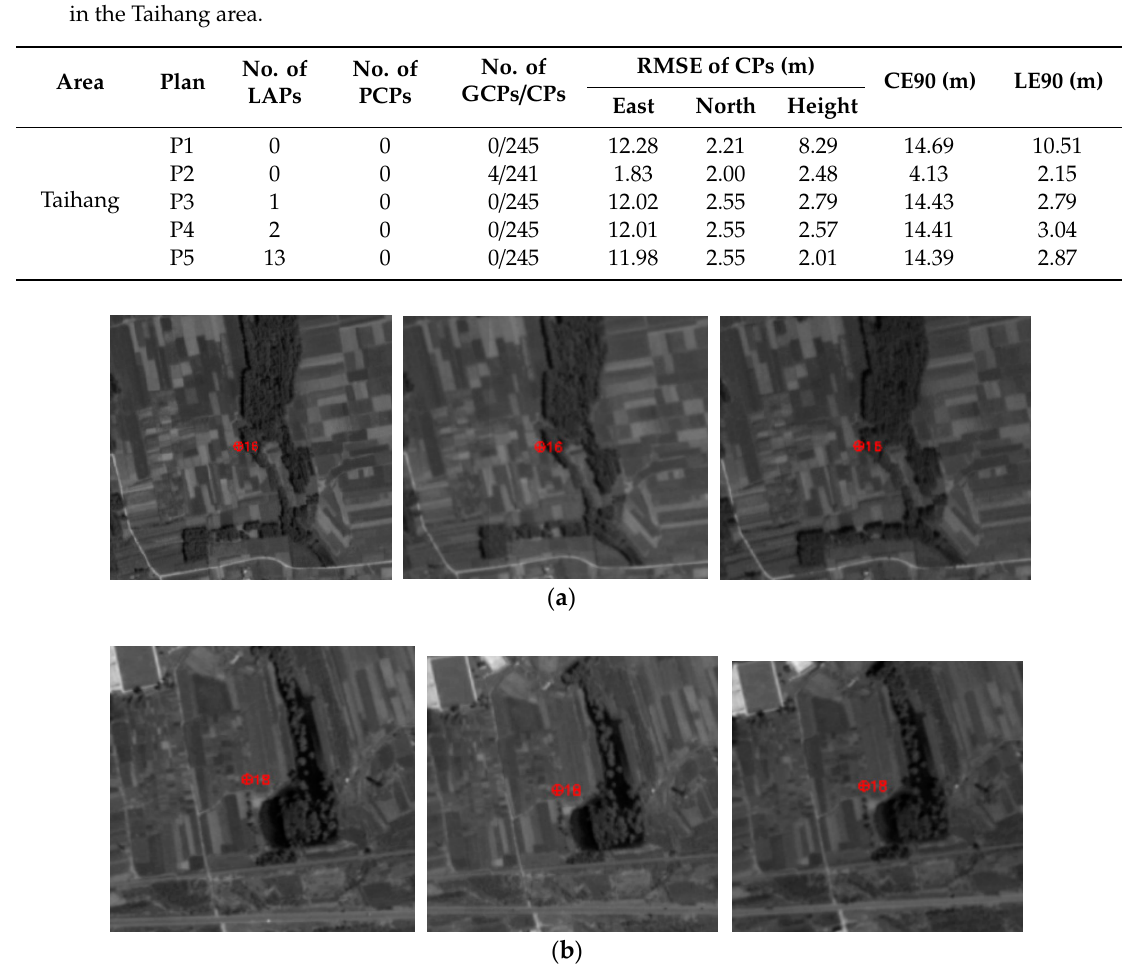
Figure 11. ZY3-02 LA points projected on the stereo images after the combined adjustment at the Taihang area. ( a ) and ( b ) are detailed views for LAPs 16 and 18 overlaid on the stereo images, where the left image shows the NAD, the center one shows BWD and the right shows the FWD image.